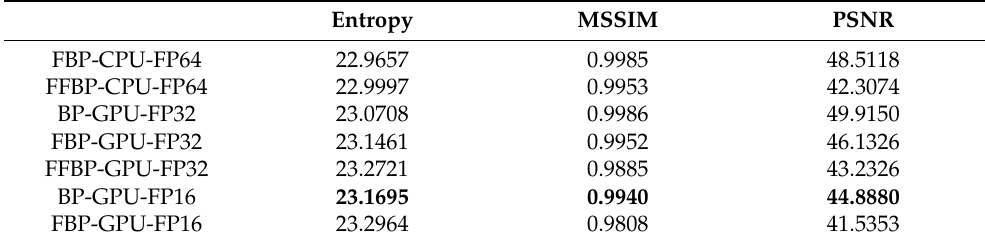
Table 6. Image quality.